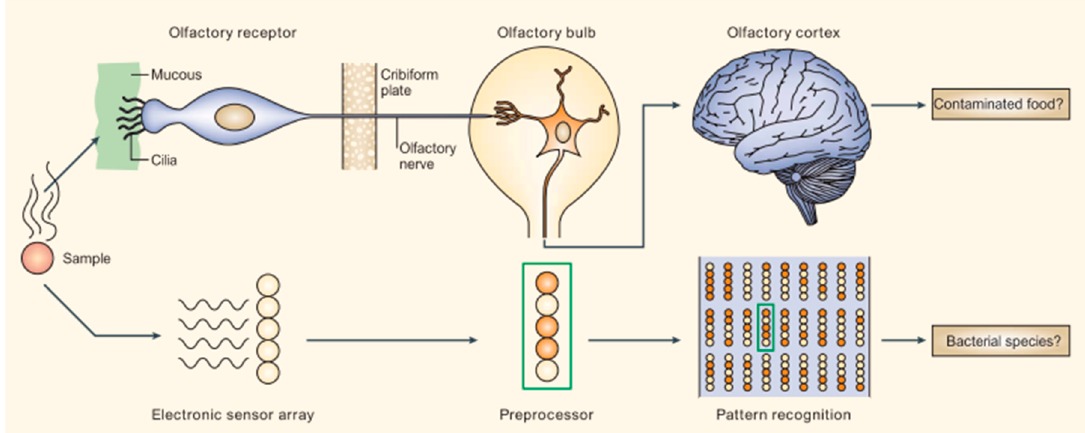
Figure 1. Parallels between mammalian olfactory system and electronic nose and tongue devices. Used with permission from [64].